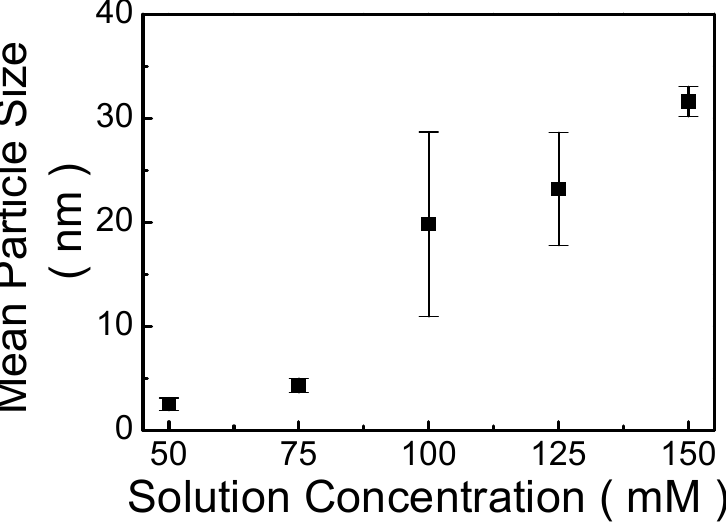
Figure 4. The mean size of the self-assembled nanoparticle as a function of solution concentration.